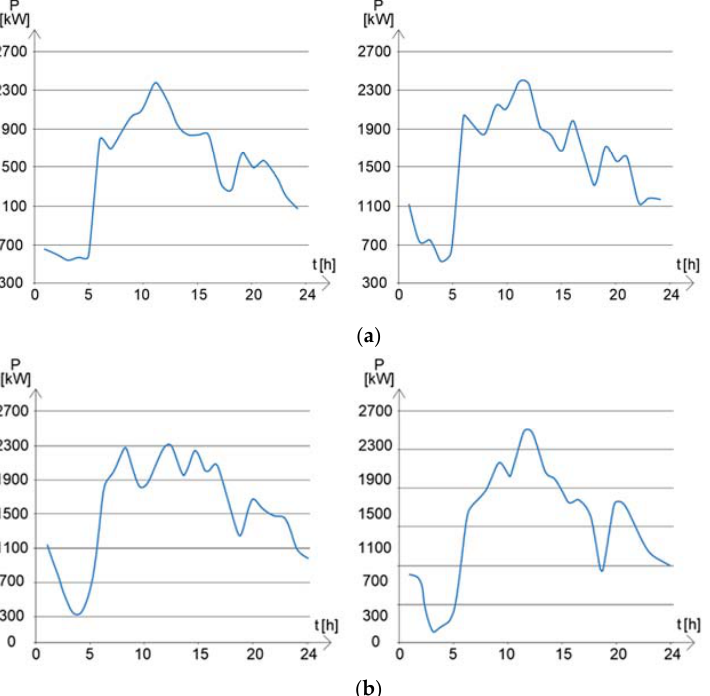
Figure 11. Examples of randomly modeled electricity consumption diagrams (Thursdays). ( a ) one example of consumption, ( b ) another example of consumption.